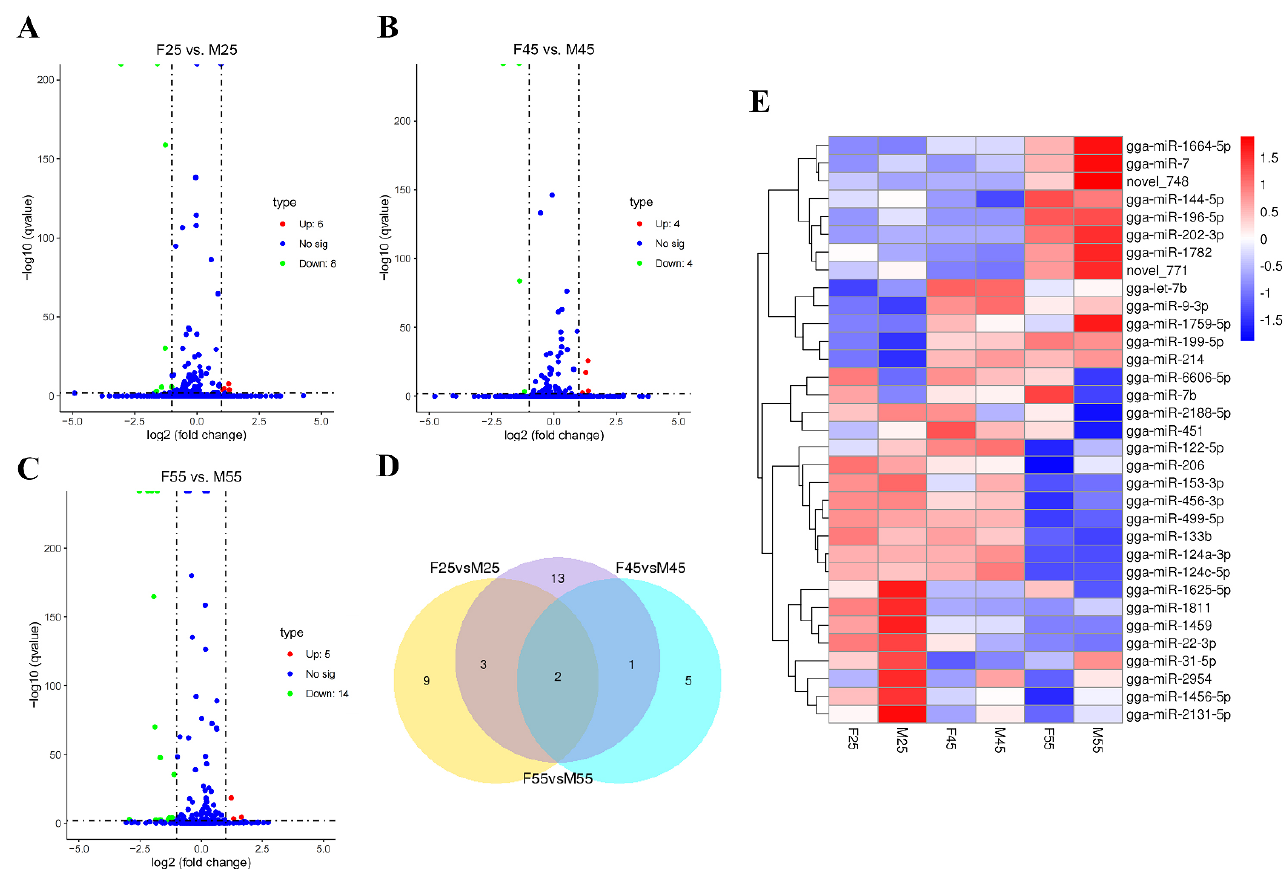
Figure 1. The differentially expressed miRNAs in chicken embryos and gonads. ( A – C ) Volcano plot of differentially expressed miRNAs in E2.5, E4.5, and E5.5 samples, respectively. The log 2 (fold change) difference between females and males is shown on the X -axis, and the negative log of q values is shown on the Y -axis. Each point shows a gene with detectable expression in both samples. ( D ) Venn diagram of differentially expressed miRNAs. ( E ) Heat map visualization of the clusters of differentially expressed miRNAs between all samples. Values plotted are log 2 fold change.